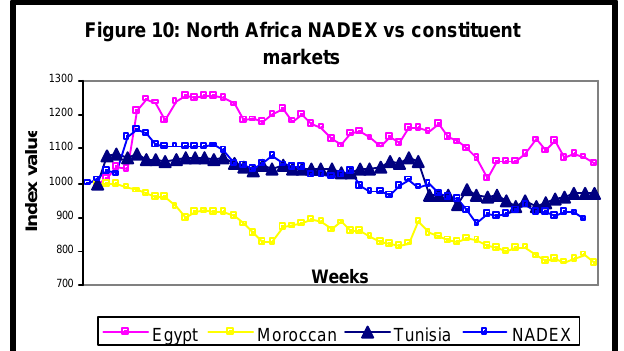
Figure 10: North Africa NADEX vs constituent